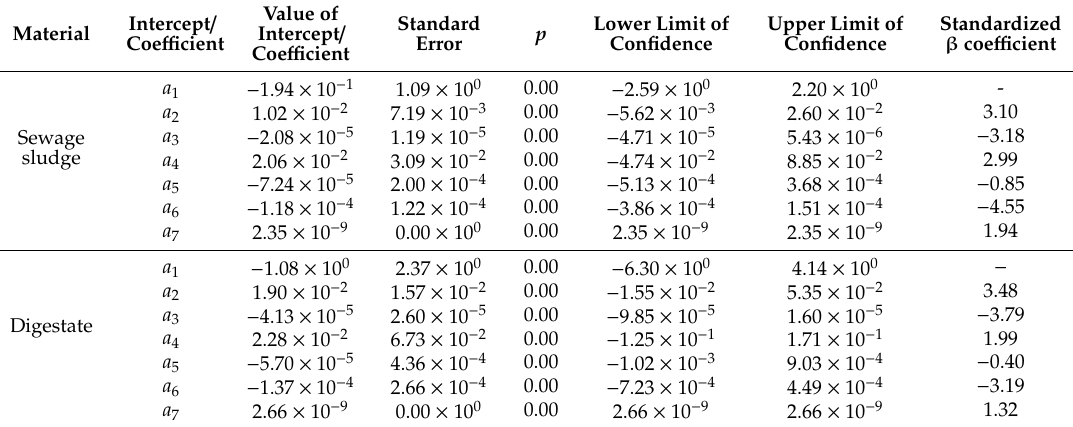
Table A3. Statistical evaluation of model coe ffi cients for the EY of CSF from sewage sludge and digestate. Material Upper Limit of Confidence Standardized β coe ffi